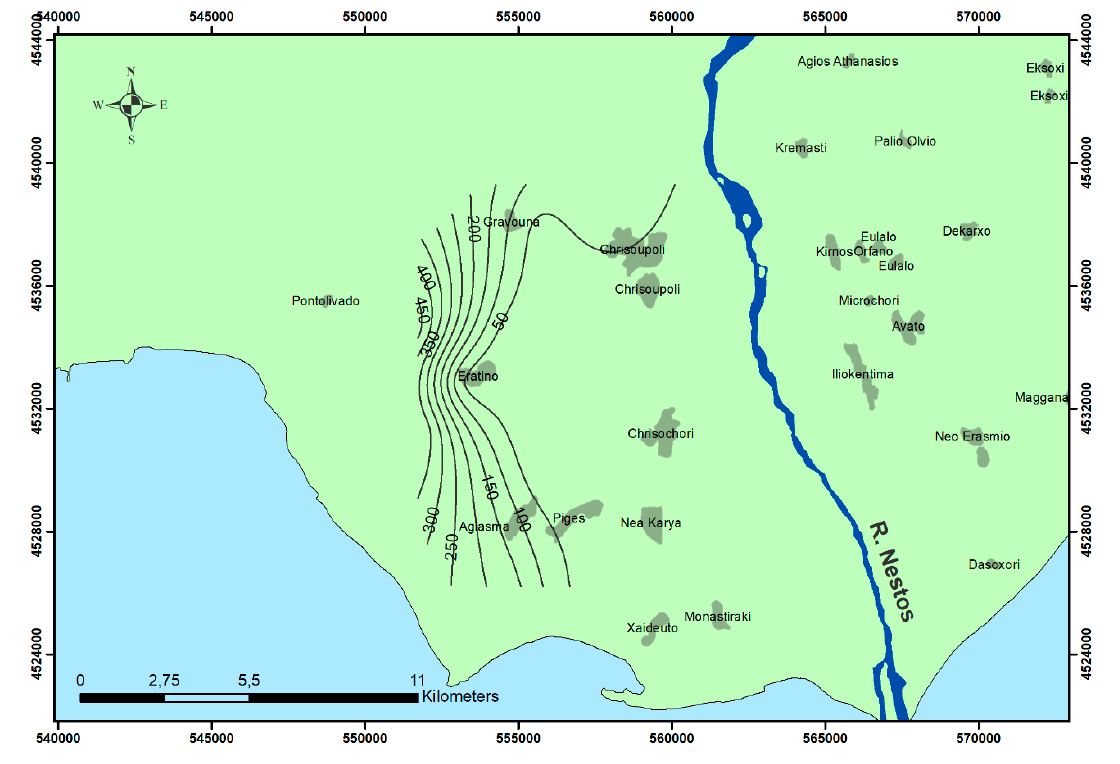
Figure 13. Chloride ion (Cl − ) distribution map (mg/L) of the unconfined aquifer (May 2019).